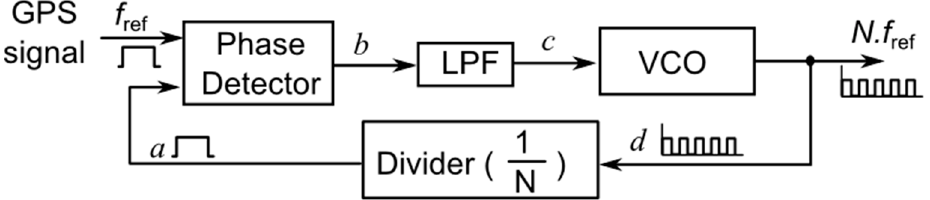
Figure 2. Frequency multiplier using phase locked loop (PLL).